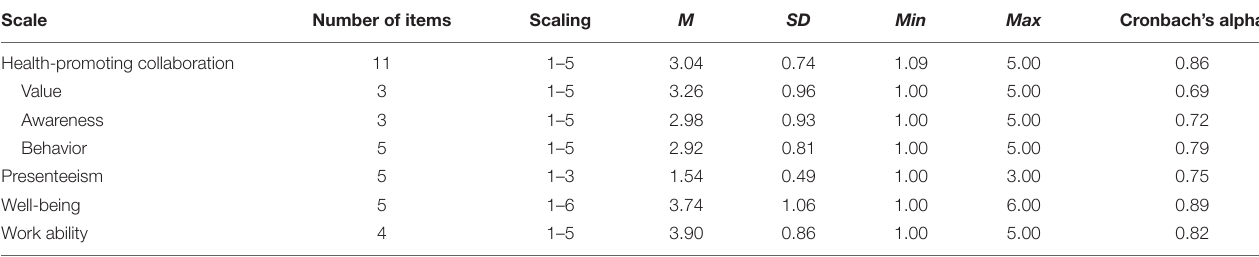
TABLE 1 | Descriptive statistics and reliability of the scales.